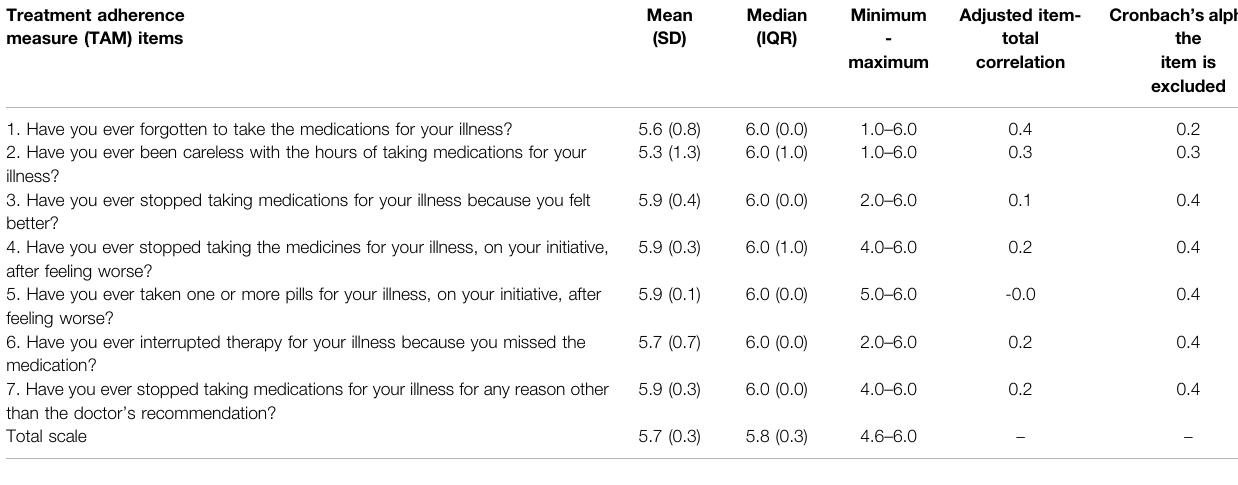
TABLE 2 | Descriptive analysis of the treatment adherence measure (TAM) instrument in patients using an immunomodulator ( n (cid:1) 84). Treatment adherence measure (TAM) items